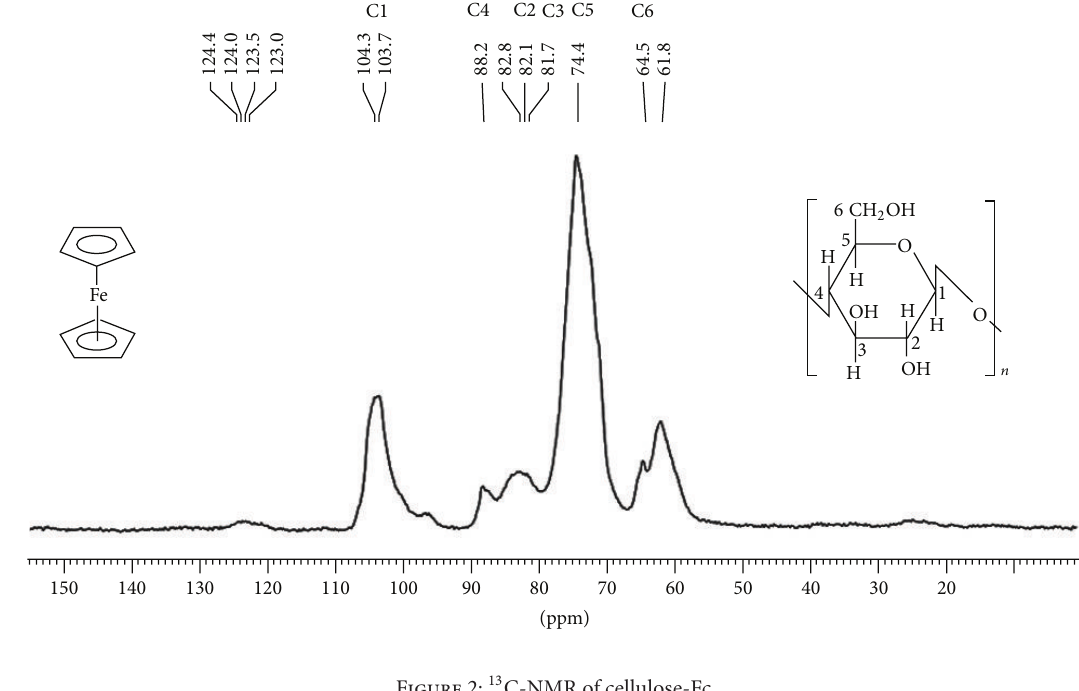
Figure 2: 13 C-NMR of cellulose-Fc.